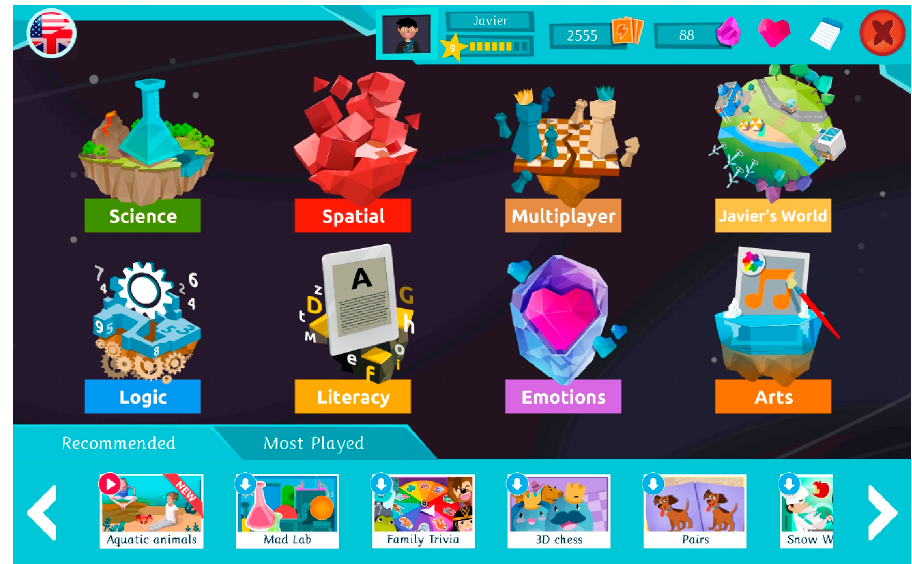
Figure 1. Screenshot of the main screen of the Smile and Learn app, showing the different worlds that can be selected, the amount of tokens ‘smileys’ and ‘gems’ earned, as well as recommendations, most played games, favorites, and homework notebook. This panel includes a language selector, an avatar picture and the level achieved.